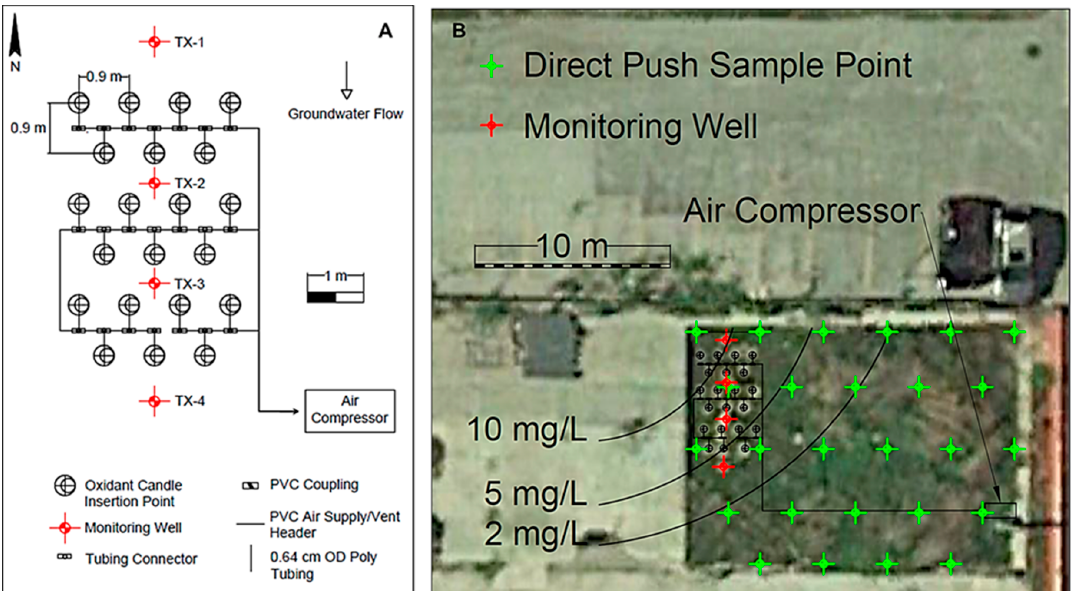
Figure 6. ( A ) Plot plan of the Textron site showing the location of monitoring wells and direct-push oxidant candles with aeration and ( B ) plan view of the Textron site showing BTEX contours and oxidant drive points (circled).